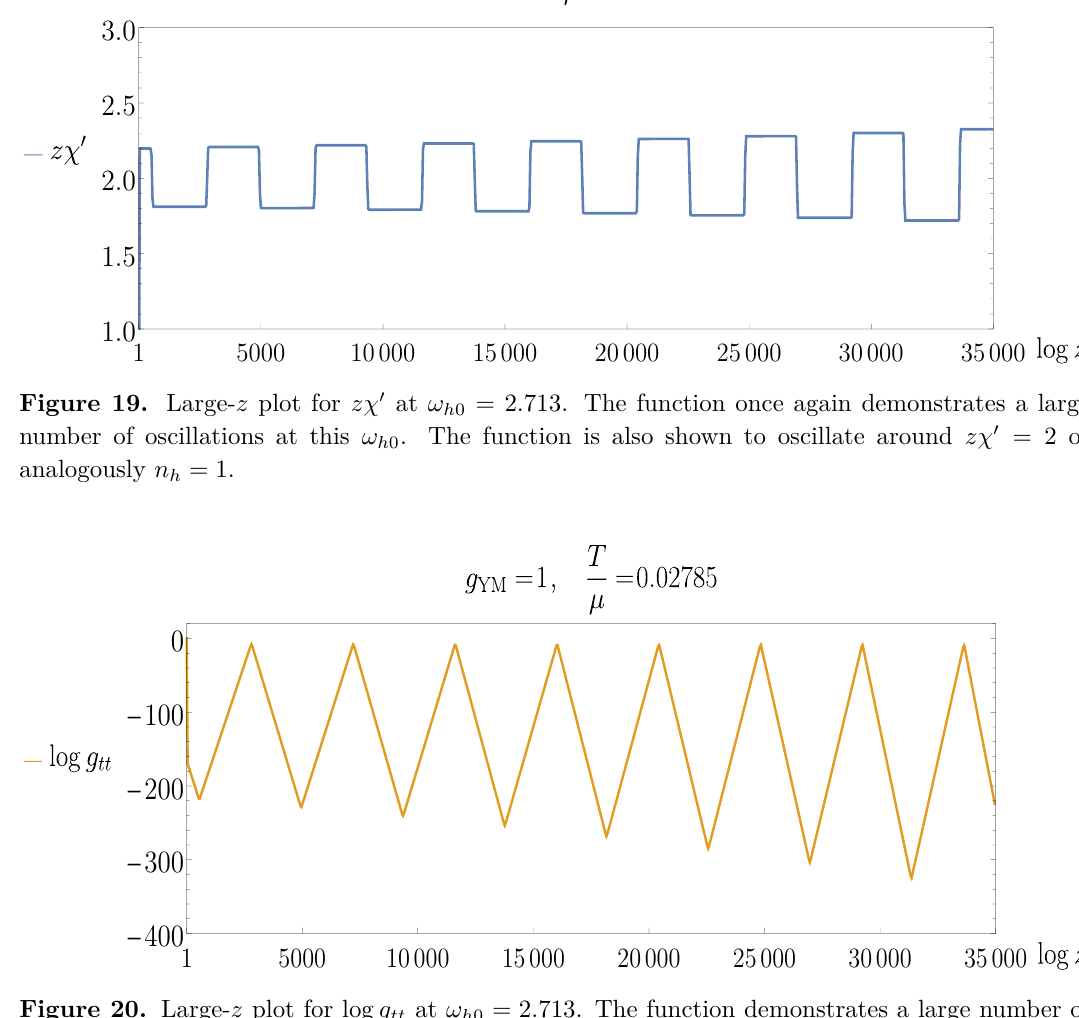
Figure 20. Large- z plot for log g tt at ω h 0 = 2 . 713 . The function demonstrates a large number of oscillations, with increasing